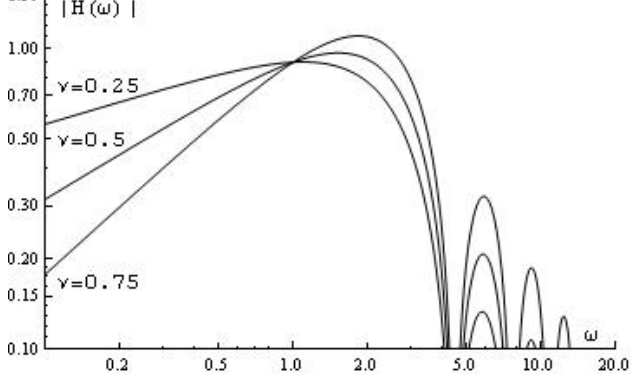
Figure 4. Moduli of the frequency responses of a fractional Legendre